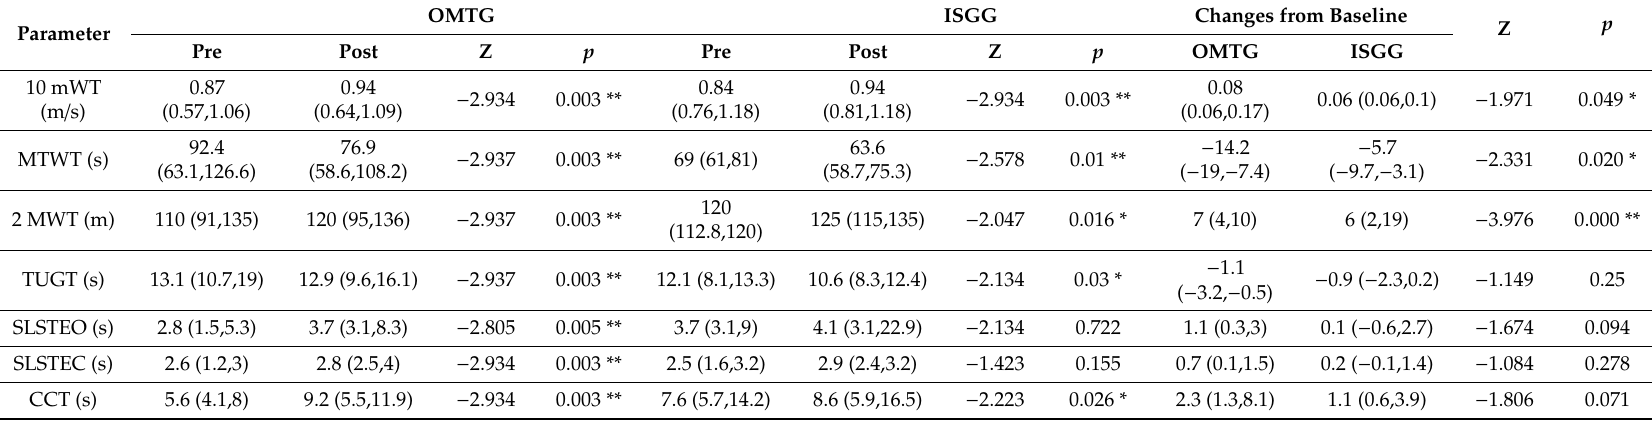
Table 3. Changesin measures of walking and balance abilities from the baseline to the end of training in the outdoor multisurface terrain group and the indoor solid ground